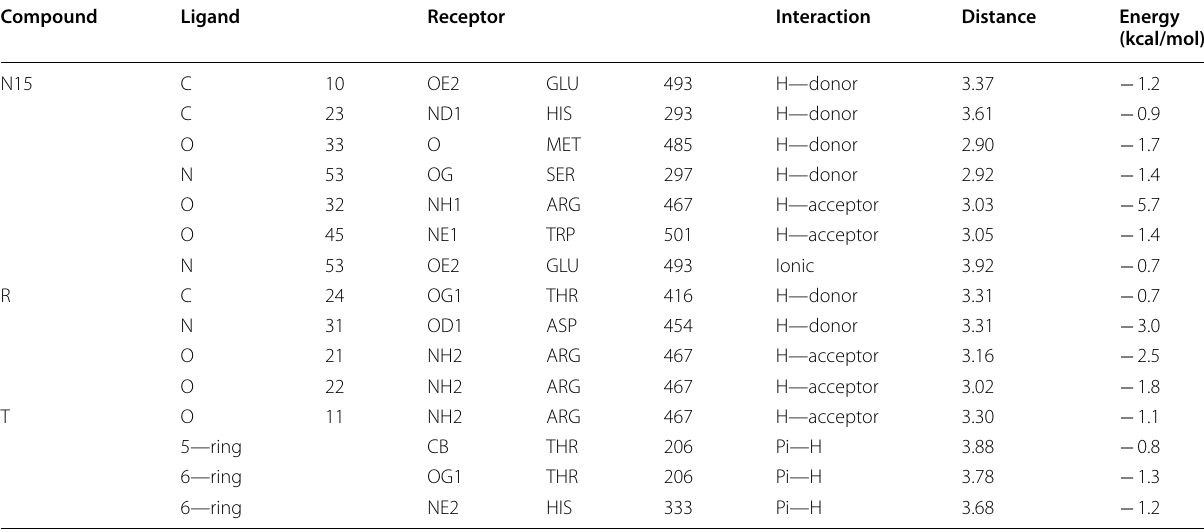
Table 4 In-depth report of the ligand–receptor interaction of new molecule 15 (N15), reference molecule ( R ) and template molecule ( T ) Compound